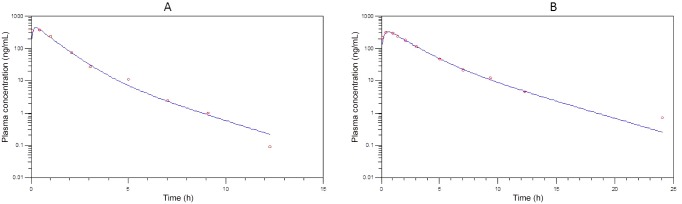
Plasma concentration versus time after dosing plot (dots) with best fit curve (lines) bird 1 (A) and 2 (B) following oral administration of flunixin at 1 mg/kg.Samples were collected sequentially, when possible, at 5 and 30 min; 1, 1.5, 2, 3, 5, 7, 9, 12, 24, 32 and 48 hours after treatment with flunixin.